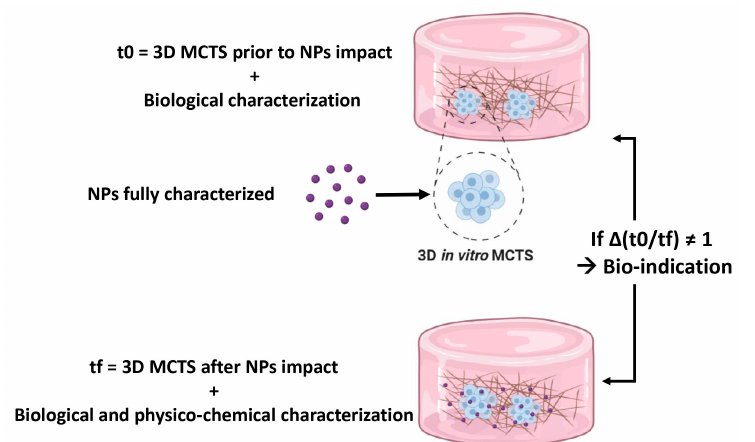
Figure 4. Initial state t0 vs. final state tf of the MCTS. In order to assess the effectiveness of the bio-indicator, a comparison between t0 and tf is inevitable for the understanding of the impact of NPs on the living in vitro 3D